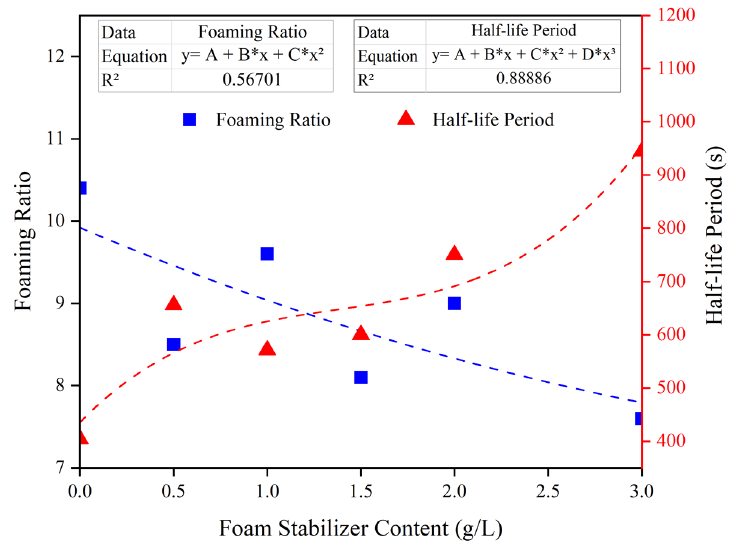
Figure 7. Effect of the foam stabilizer content on the volume and the half-life period of the foam.